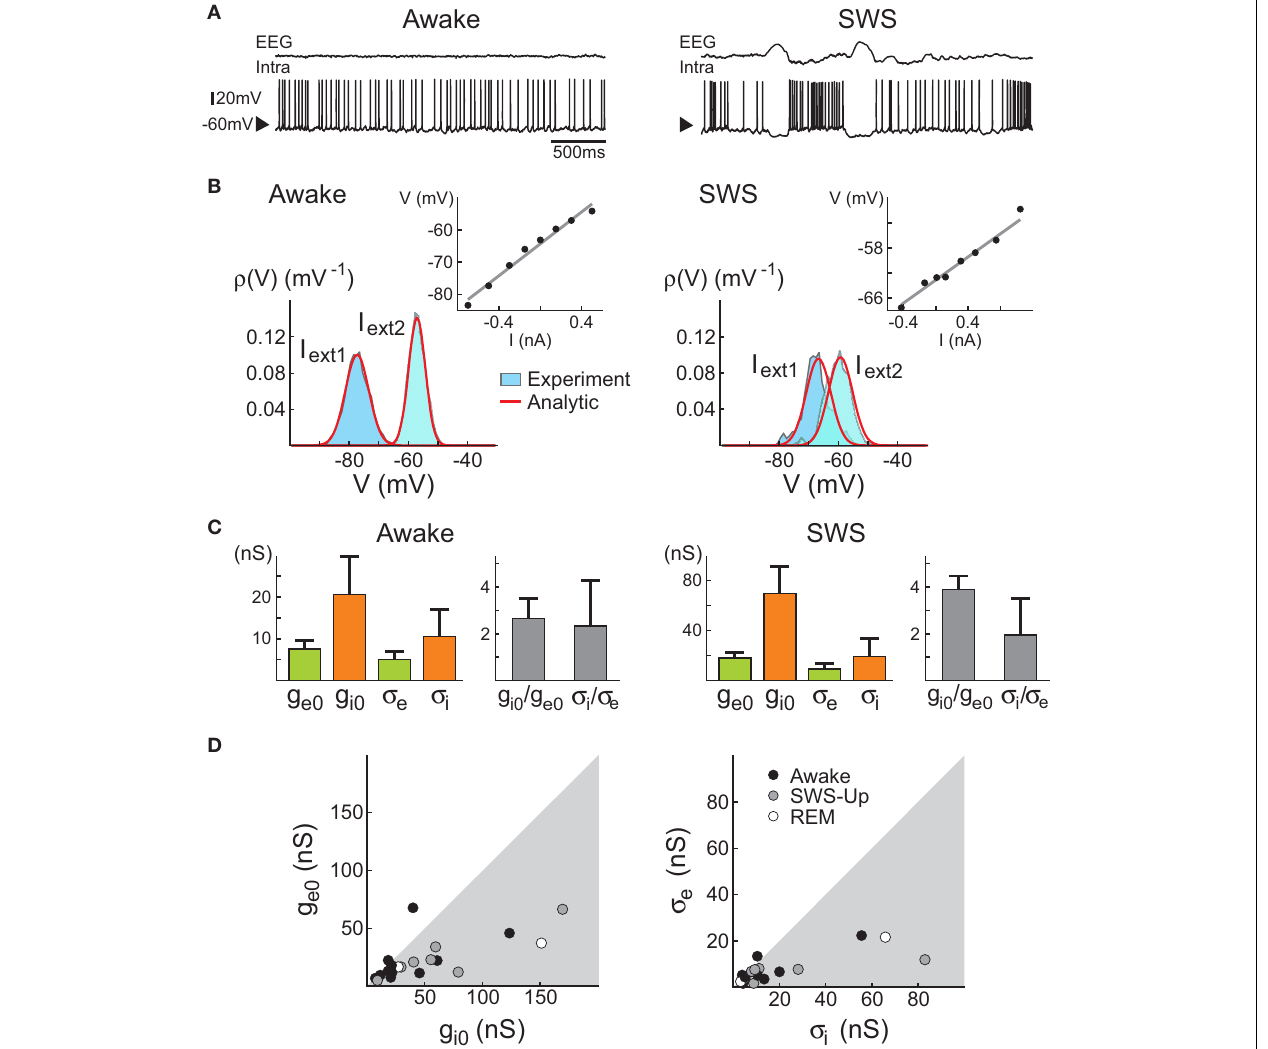
FIGURE 1 | VmD estimation of conductances from intracellular recordings in awake and naturally sleeping cats. (A) Intracellular recordings in awake and naturally sleeping (SWS) cats. Recordings were made in association cortex (area 5–7). (B) Examples of V distributions computed during wakefulness (Awake) m and slow-wave sleep up-states (SWS). The continuous lines show Gaussian fi ts of the experimental distributions. Insets: current–voltage relations obtained for these particular neurons. (C) Conductance values estimated using the VmD